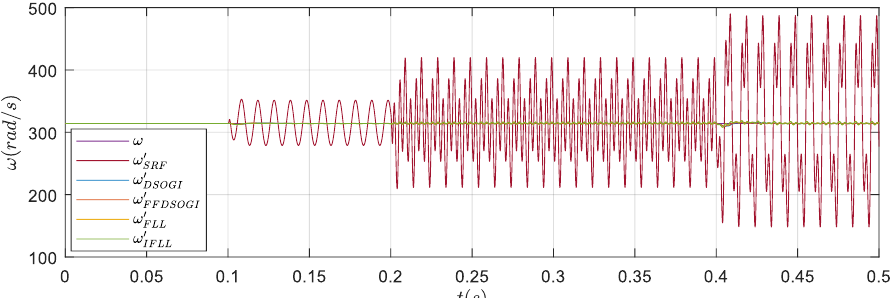
Figure 10. Estimated frequency for the different methods during test